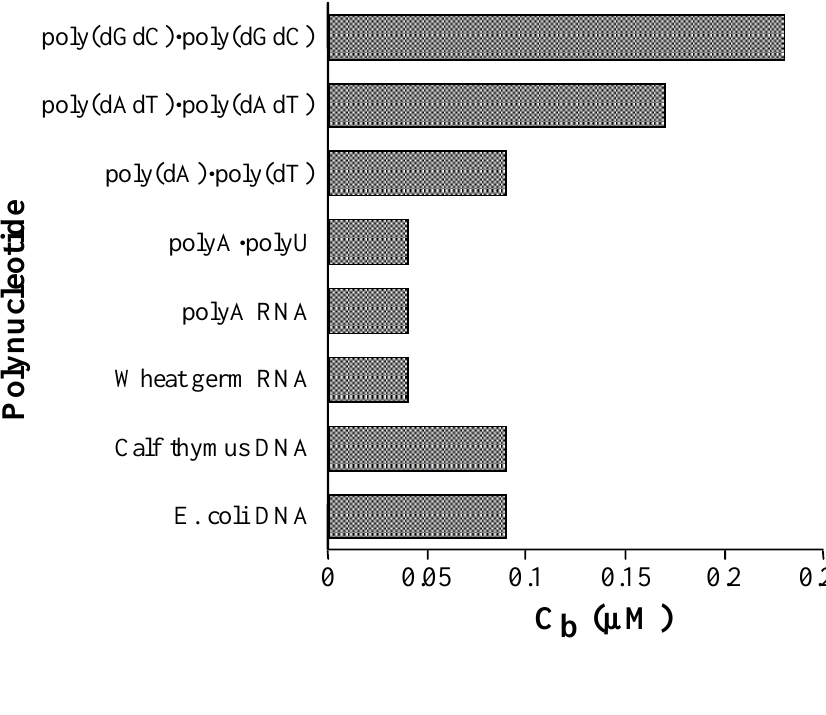
Scheme 6 : Competition dialysis representing interaction between 14 and eight nucleic